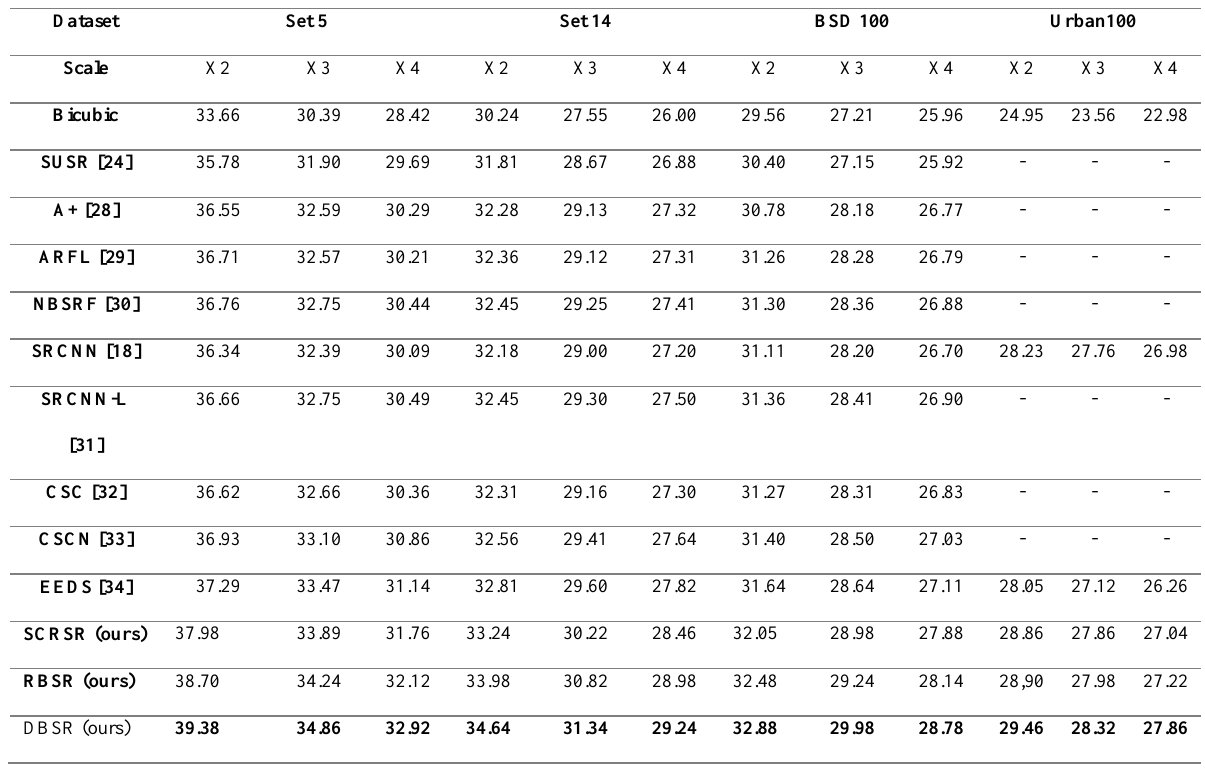
Table 3. Evaluation results on four datasets using PSNR metric and three scale factors 2, 3, and 4.